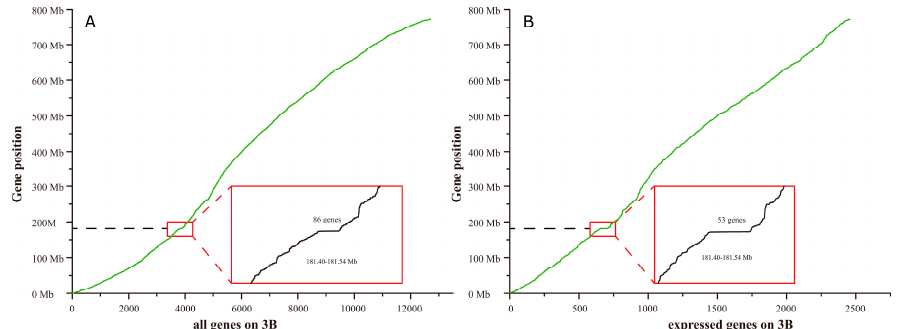
Figure 6. Distribution of genes on wheat chromosome 3B. ( A ) Eighty-six genes annotated by the Genetics Diversity Ecophysiology of Cereals (GDEC) group at the French National Institute of Agronomic Research (INRA) located in region 181.40–181.54 Mb of wheat chromosome 3B. ( B ) Fifty-three expressed genes located in region 181.40–181.54 of chromosome 3B in this study. The insets show enlargements of the boxed